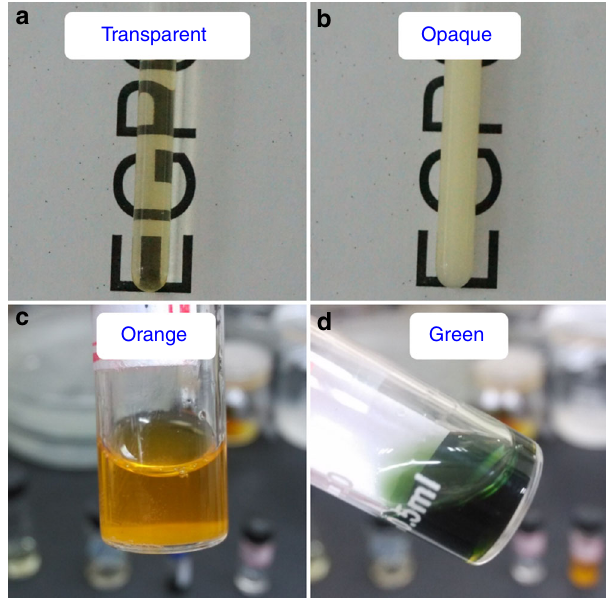
Fig. 4 Stimuli-responsive properties of EGP6 and ferrocene in solution. Transparency of EGP6 aqueous solution (4 mM): a at 25 °C and b at 40 °C; colors of mPEG-Fc solution at c reduction state and d oxidation state,